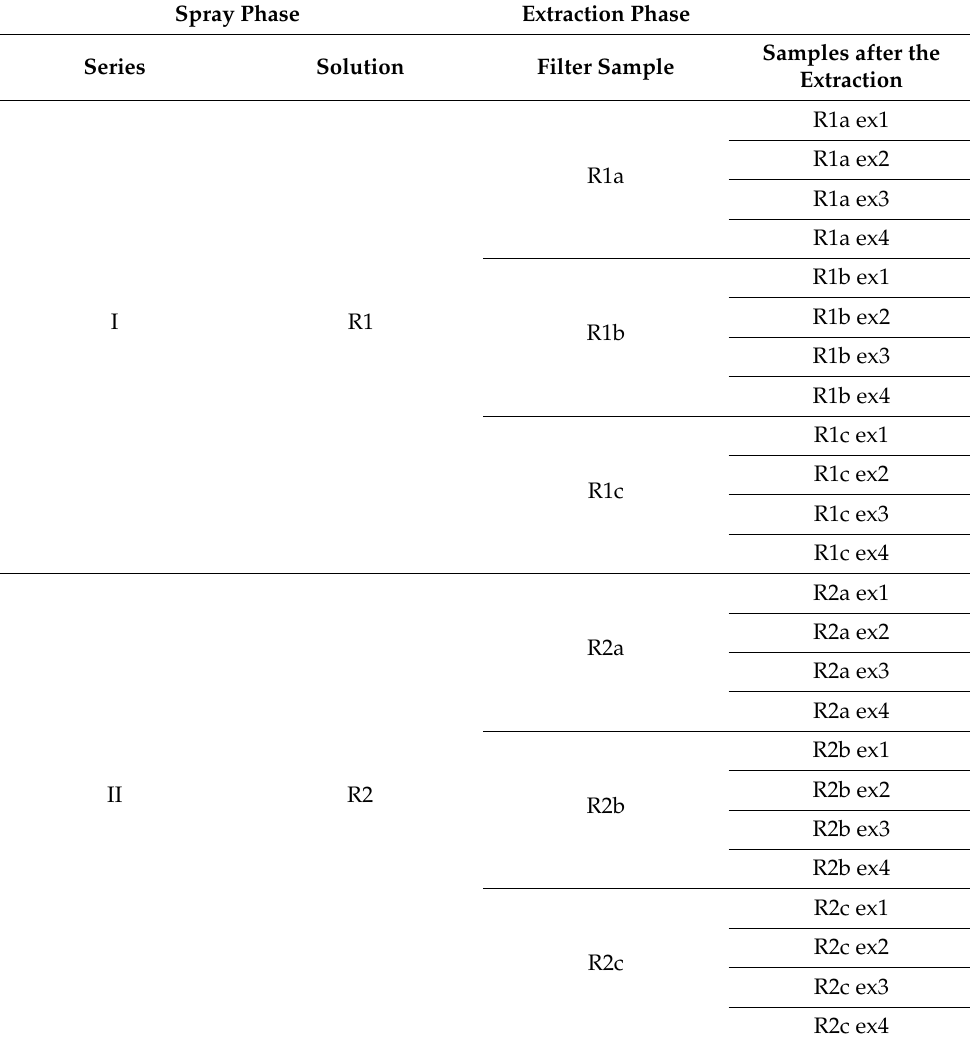
Table 4. Identification of solutions obtained after the extraction of silica from the